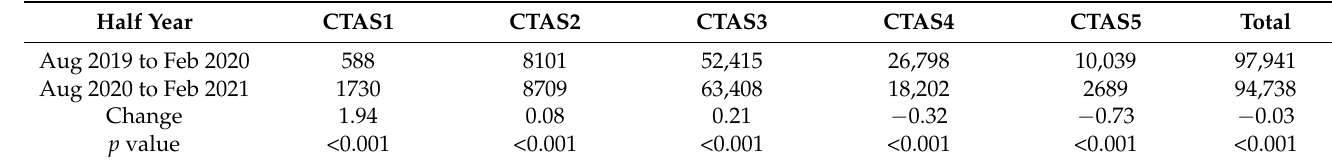
Table 1. Comparing CTAS data